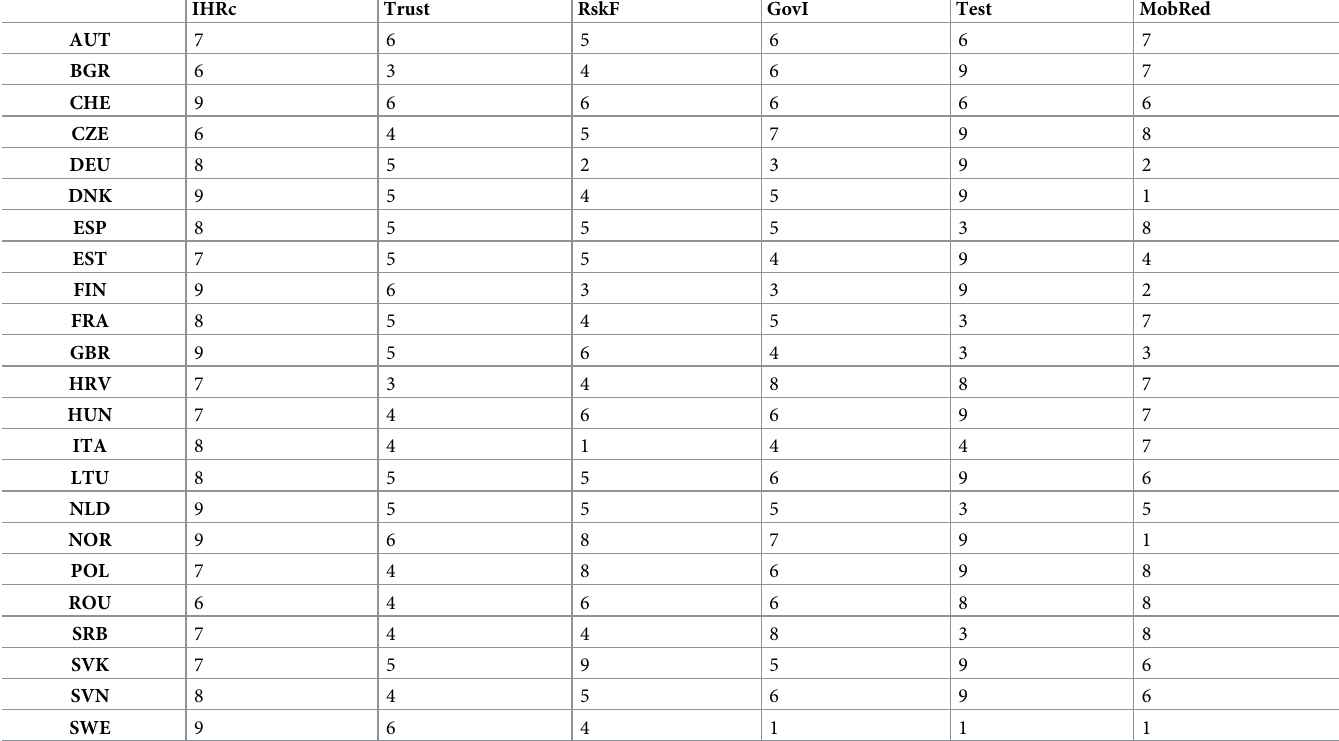
Table 5. Performance